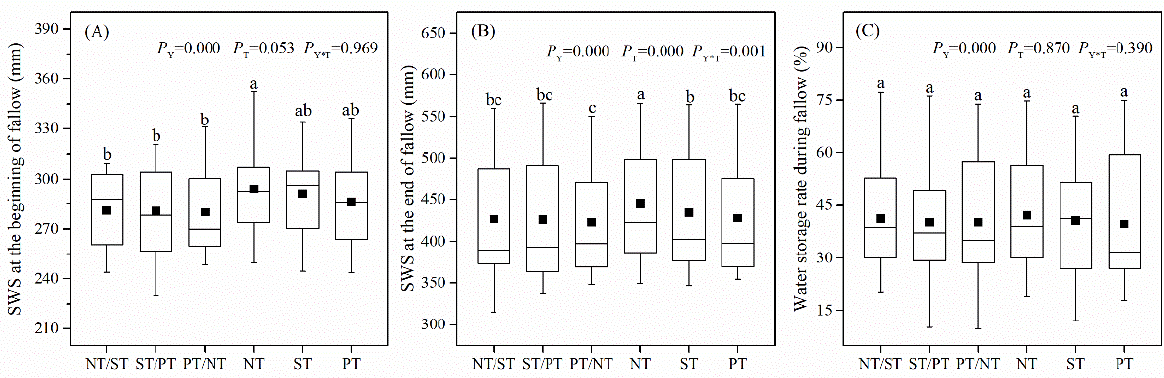
Figure 3. Soil water storage (SWS) at the beginning ( A ) and the end ( B ) of fallow, and the water